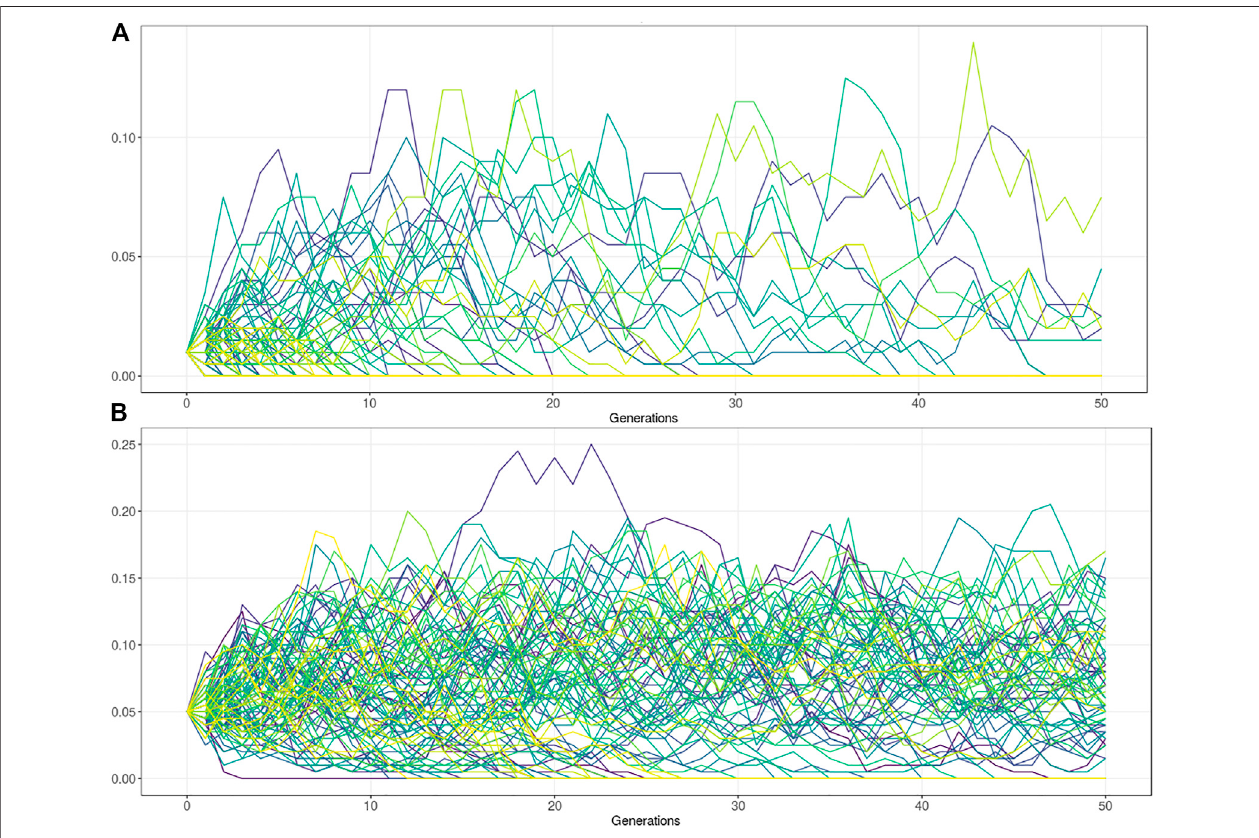
FIGURE4| PopulationgeneticsimulationsfordeleteriousalleleswithNe (cid:1) 100. (A) Frequencysimulationofadeleteriousalleleatstartingfrequency1%.The fi tness ofthehomozygousBBgenotype (cid:1) 0,withequal fi tnessfortheABandAAgenotype( fi tness (cid:1) 1).Figureshowsthatthealleleislostinthevastmajorityofthepopulations after 50generations. Themaximum frequencyreached bydrift isapproximately 10%. (B) Frequencysimulationofa deleterious allele with the fi tnessofthe homozygous BB genotype (cid:1) 0, and the AB genotype has a 10% fi tness advantage over the homozygous AA genotype (AB (cid:1) 1, AA (cid:1) 0.9). Figure shows that the allele is lost in aboutonethirdofthepopulationsafter50generations.Intwothirdofthepopulationsthealleleremainsatarelativelystableequilibriumbetween5 –